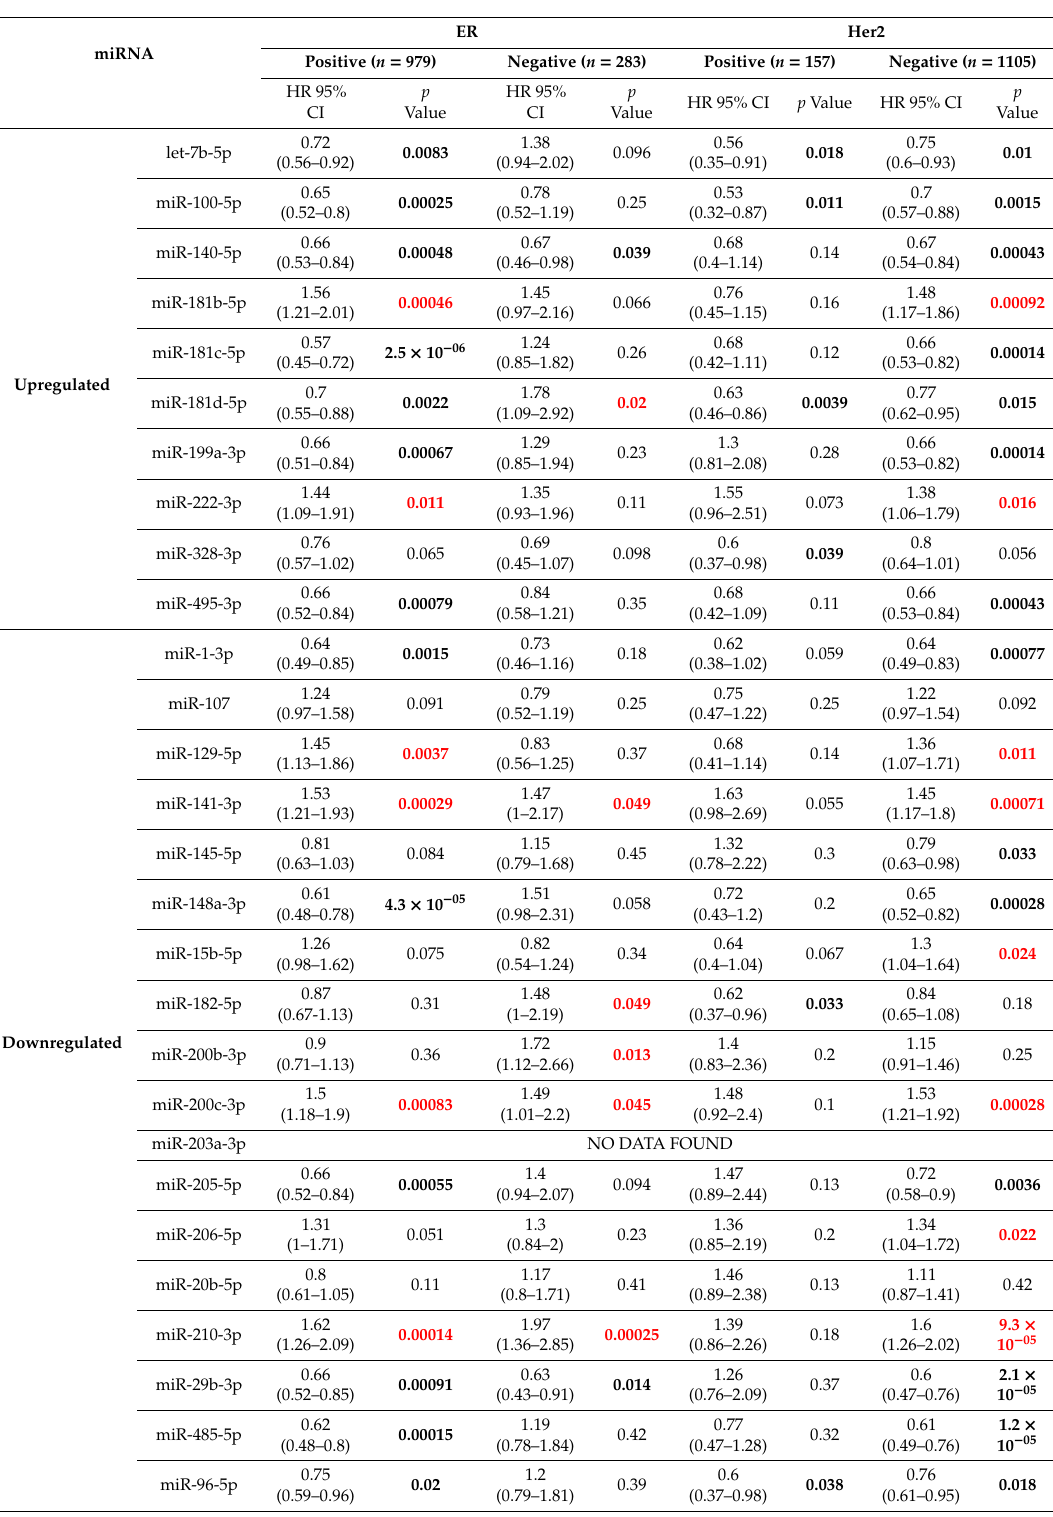
Table 6. The prognostic value of the expression of up- and downregulated miRNAs in breast cancer patients stratified by estrogen receptor (ER) and human epidermal growth factor receptor 2 (Her2) expression